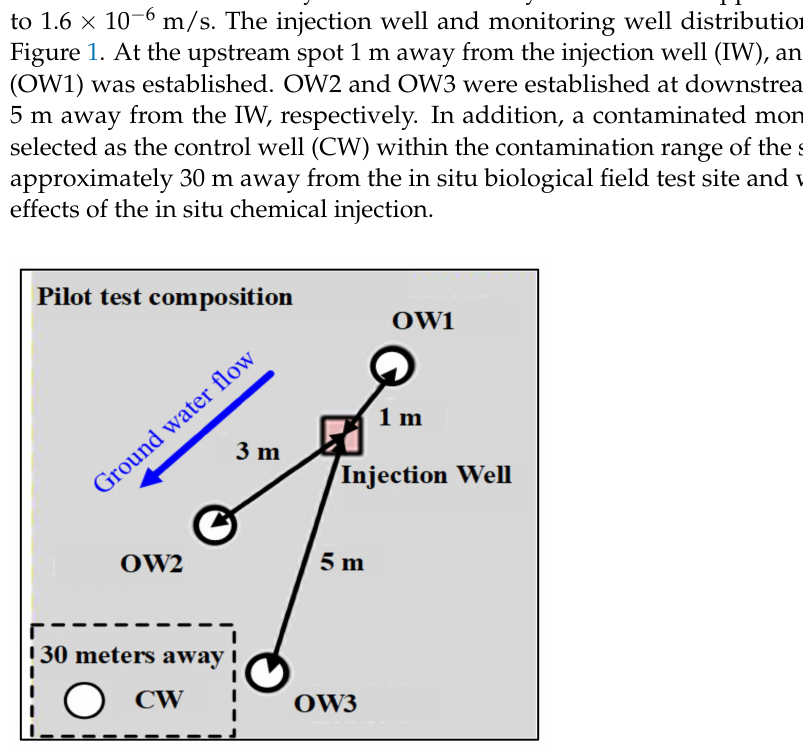
Figure 1. In situ biological field test well